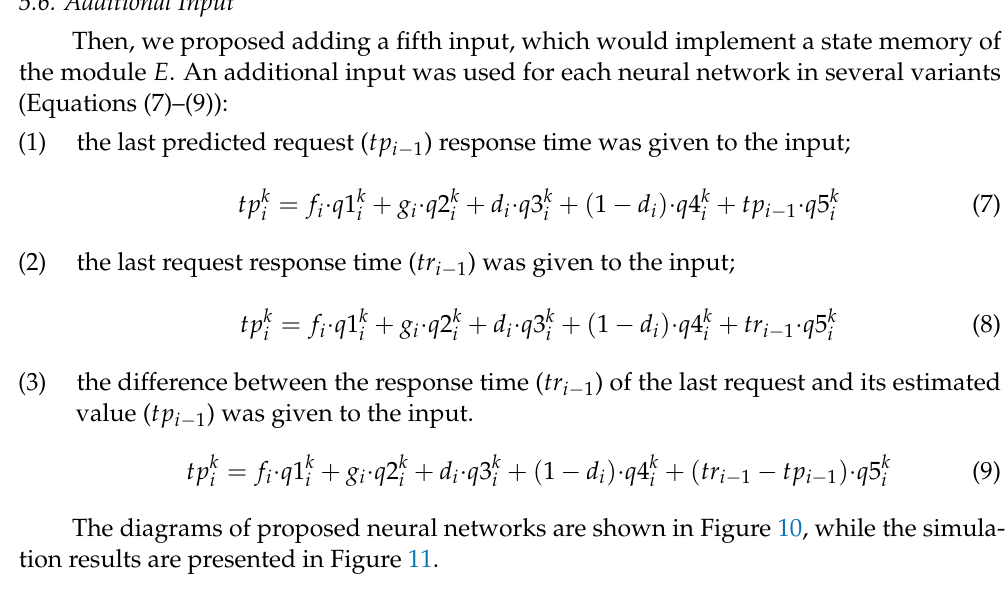
Figure 9. The division into groups with a balanced total time of requests processing.